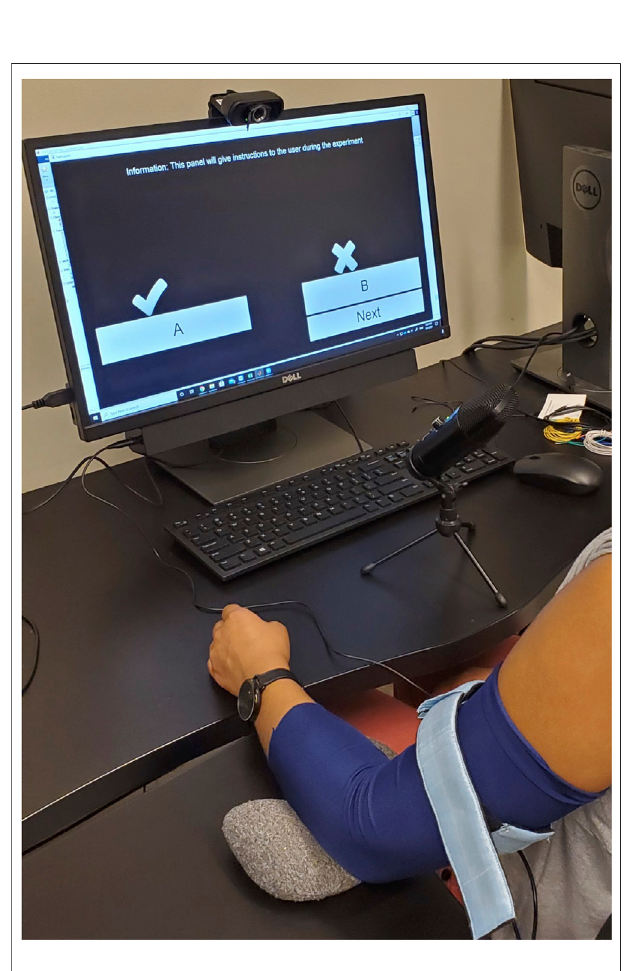
FIGURE 3 | Experimental setup in Exp. 3. The tactor band was worn on top of the left biceps. The computer screen shows the interface for pairwise